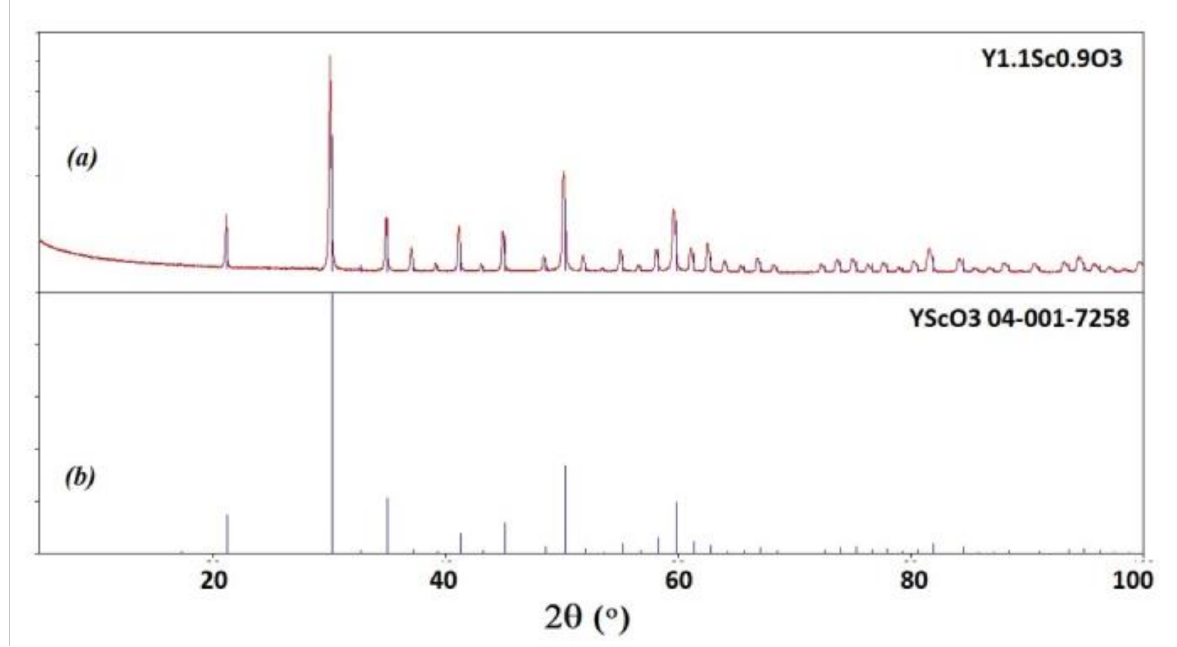
Figure 4. Powder diffraction patterns of Y 1.1 Sc 0.9 O 3 ( a ) in comparison with PDF 04-001-7258 YScO 3 reference ( b